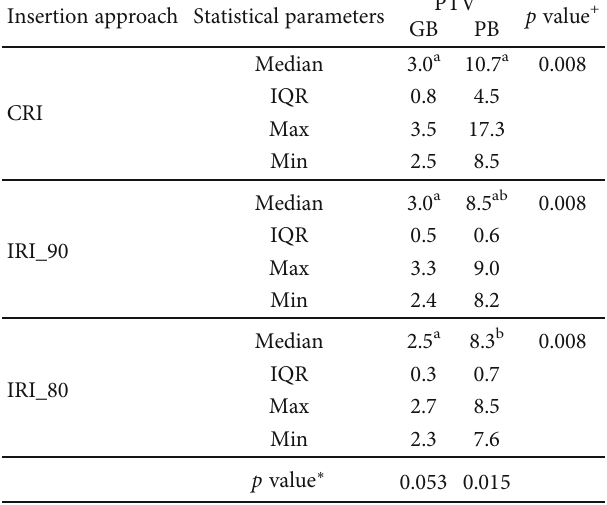
Table 3: PTV of the three insertion approaches for GB and PB. Insertion approach Statistical